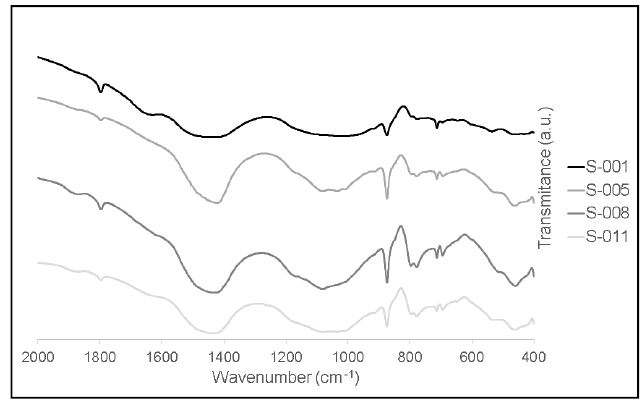
Figure 10. FTIR spectra’s of samples. S-001 (South), S-005 (East), S-008 (North), and S-011